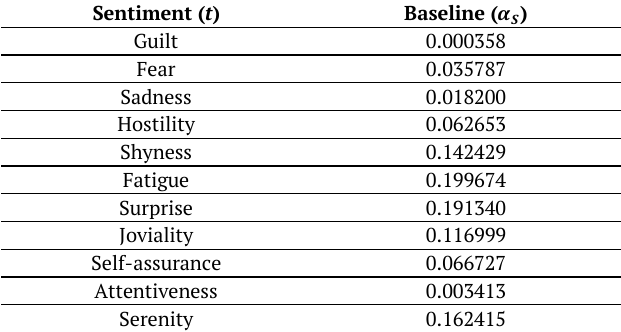
Table 1. Baseline Scenario – Fraction of Tweets for